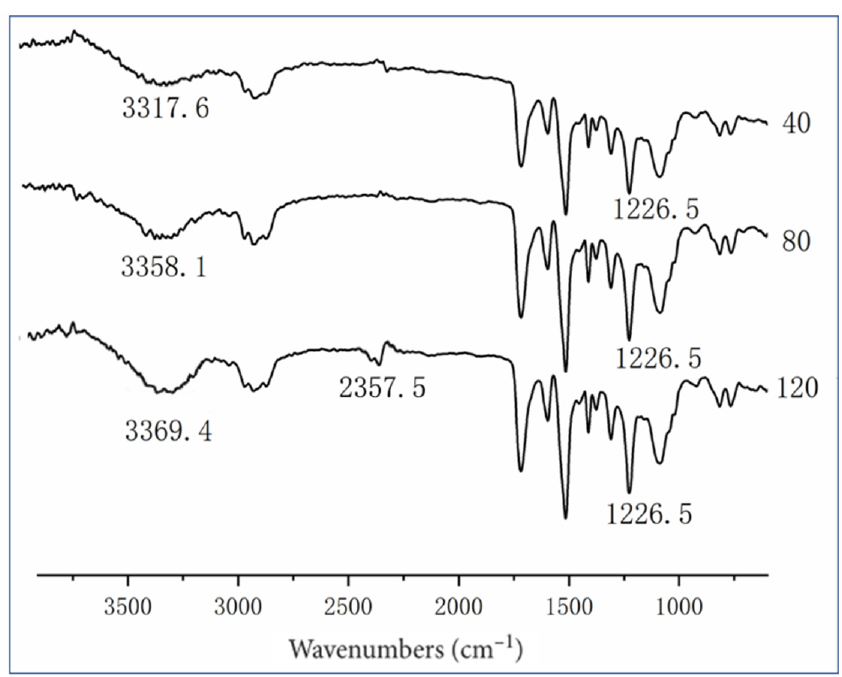
Figure 5. ATR-FTIR spectra of polyurethane powders with different mesh numbers.